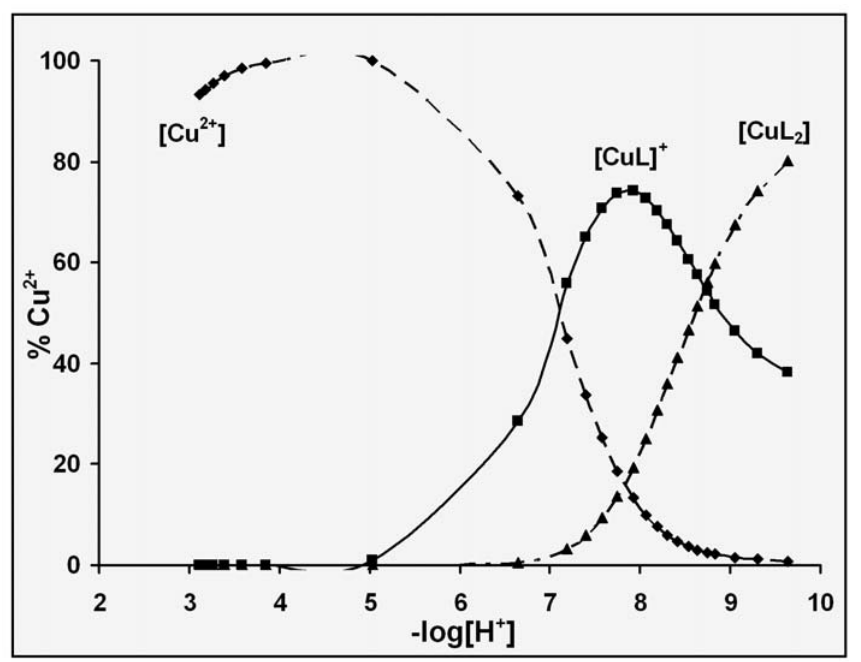
Fig. 2 Distribution of the species in the mixed solvent 50 w/w MeOH/H 2 O.